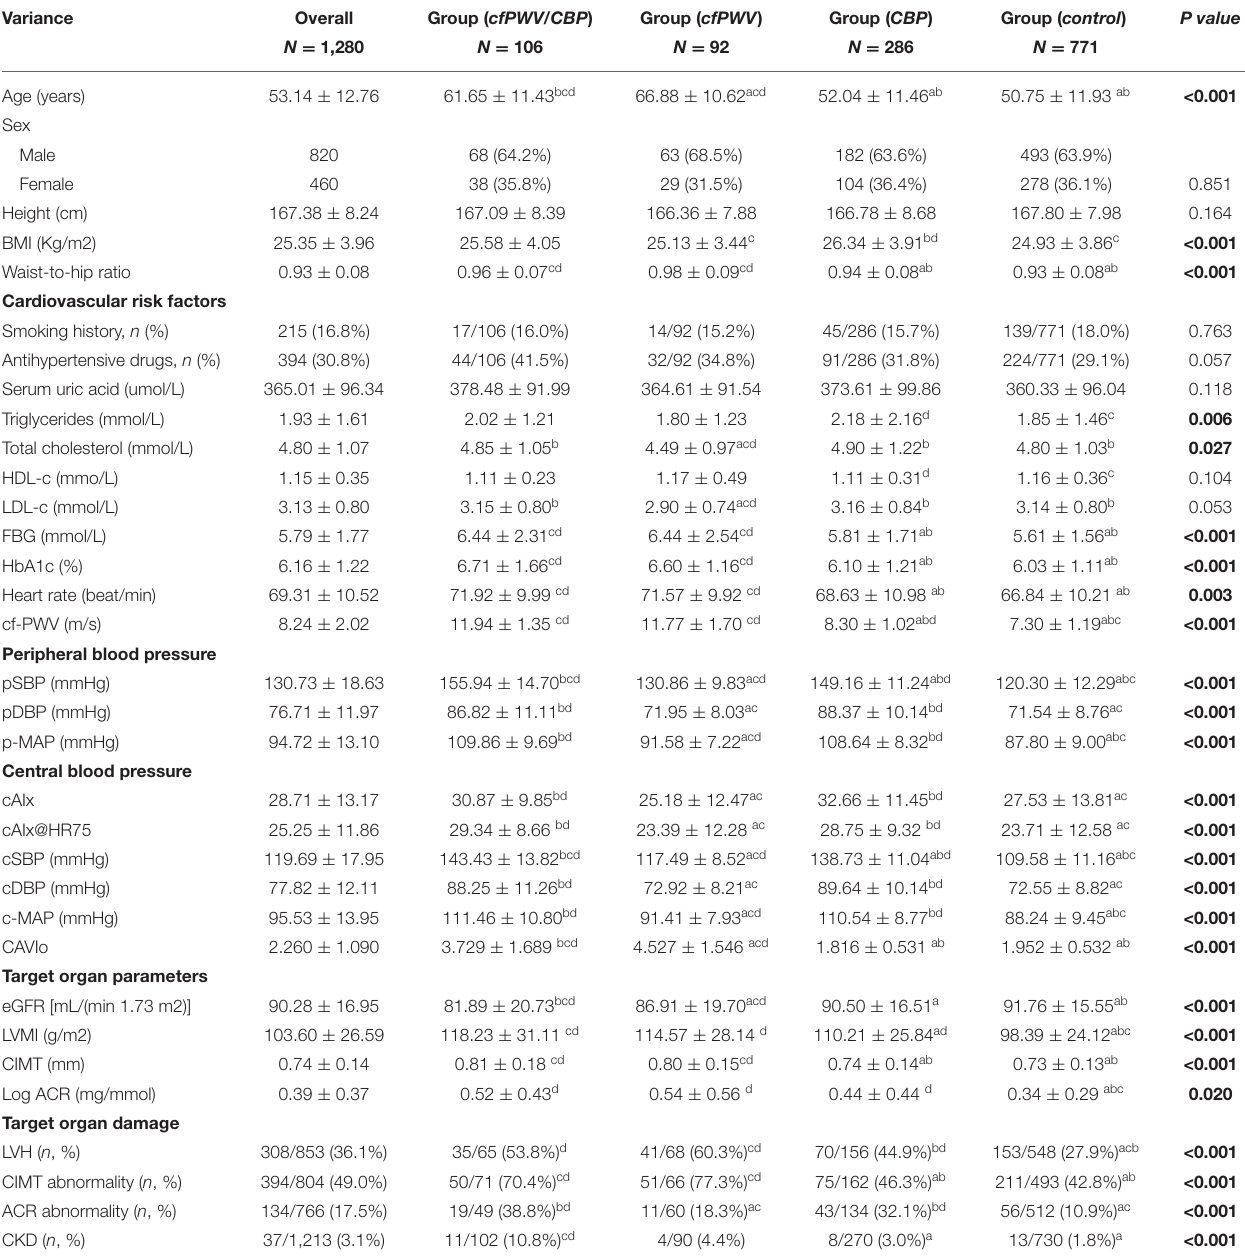
TABLE 1 | Baseline characteristics of the studied